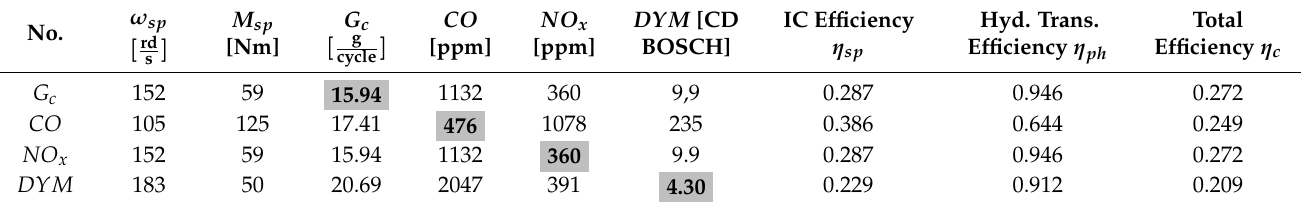
Table 6. Optimal combustion engine duty points for load I and accumulator capacity V a = 0.02 [m 3 ].